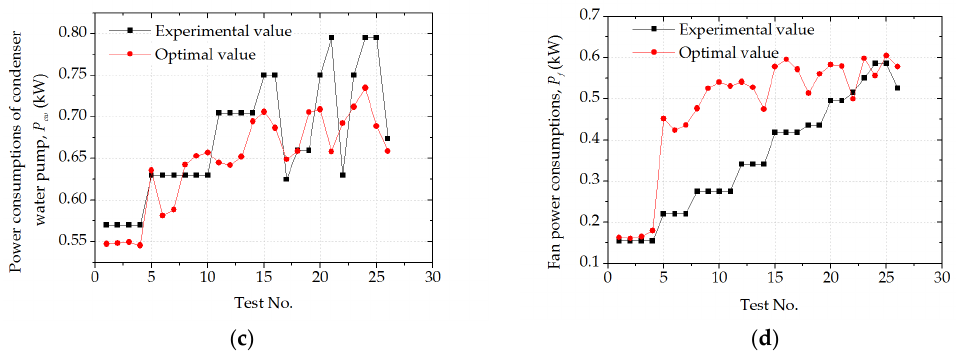
Figure 11. Power consumptions of the devices: ( a ) system; ( b ) compressor; ( c ) condenser water pump; and ( d ) cooling tower fan.